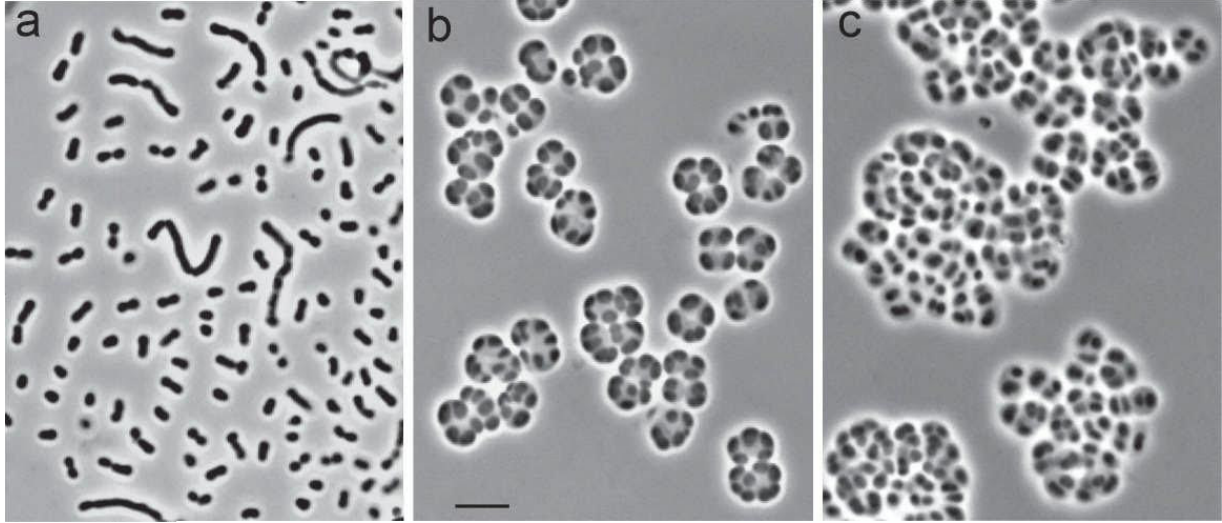
Figure 2. Phase-contrast images of polymorphic cells of Acidisarcina polymorpha SBC82 T grown for 10 days ( a ), 20 days ( b ), and 40 days ( c ) on the solid medium MA. Bar, 5 μ m.